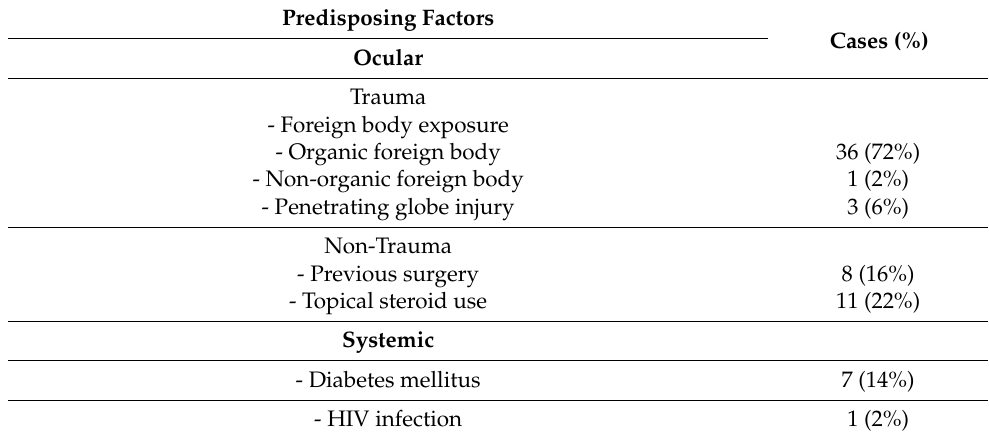
Table 2. Predisposing factors in patients with dematiaceous fungal keratitis ( N = 50).